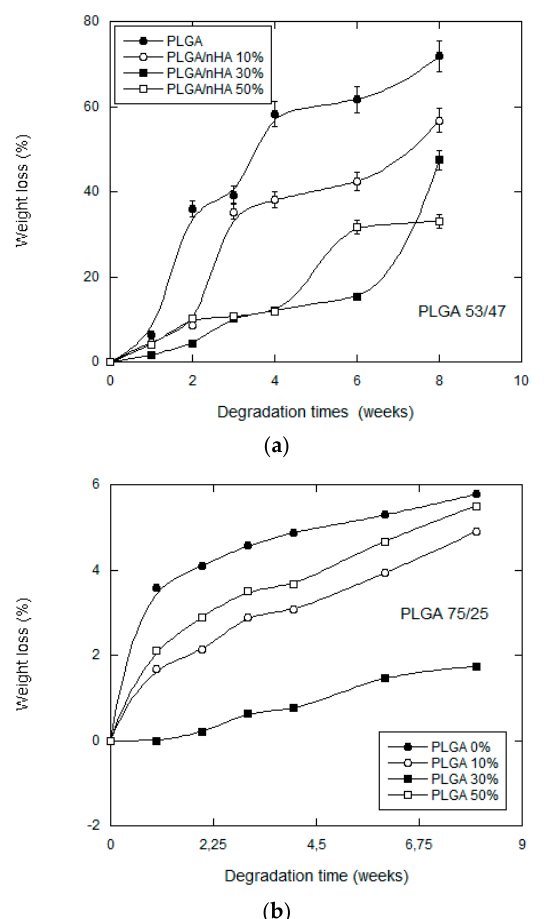
Figure 3. Mass loss of: ( a ) PLGA (53/47)/nHA; and ( b ) PLGA (75/25)/nHA, composite scaffolds against degradation time.